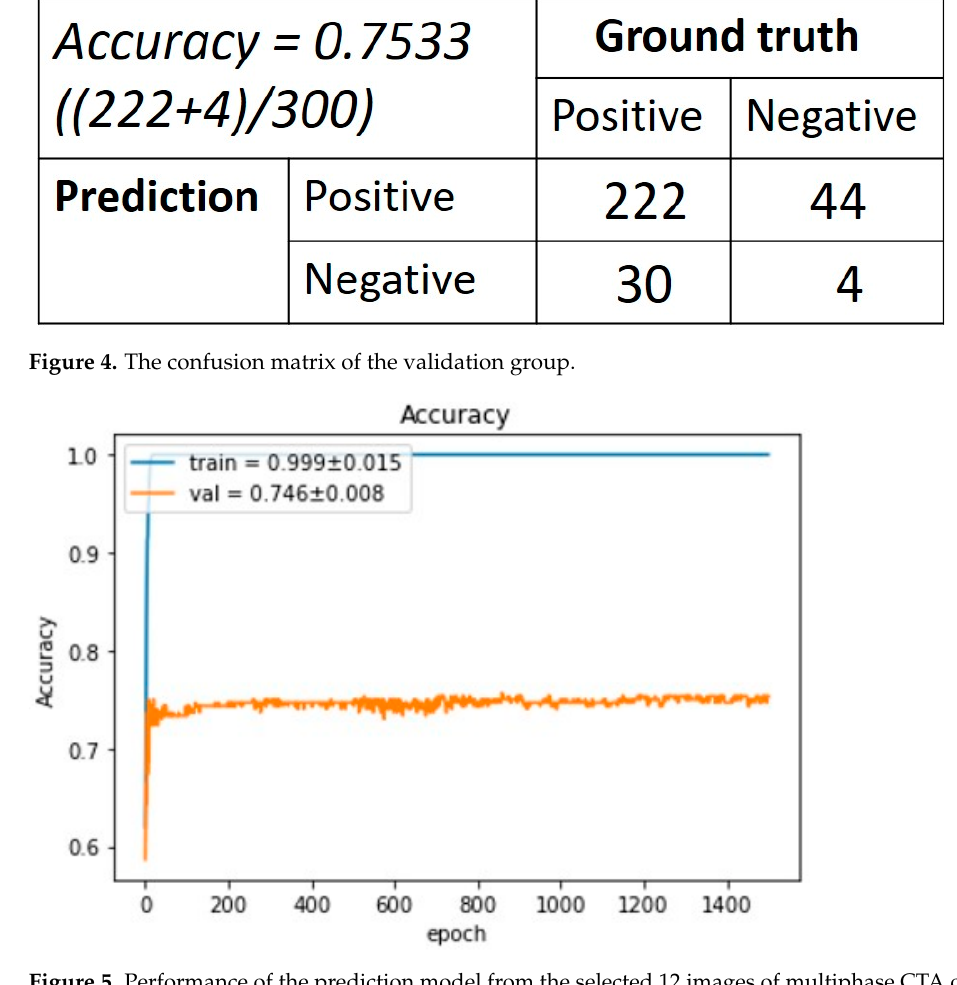
Figure 5. Performance of the prediction model from the selected 12 images of multiphase CTA on the prediction of collateral status.